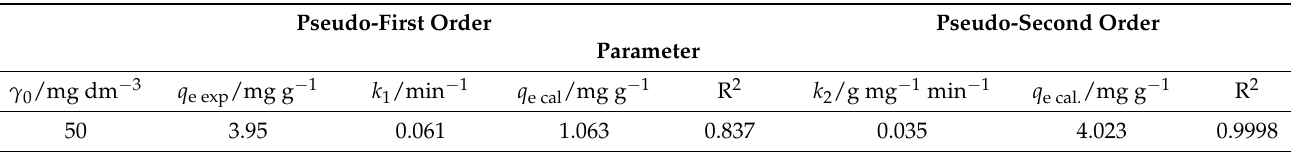
Table 3. Parameters of the pseudo-first-order and pseudo-second-order kinetic models for the removal of CR by EP